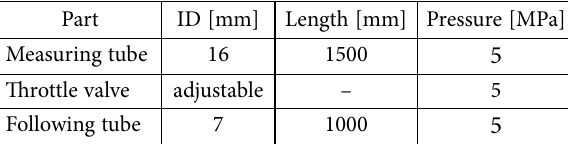
Figure 1. Schematic of the Bosch-type injection rate meter